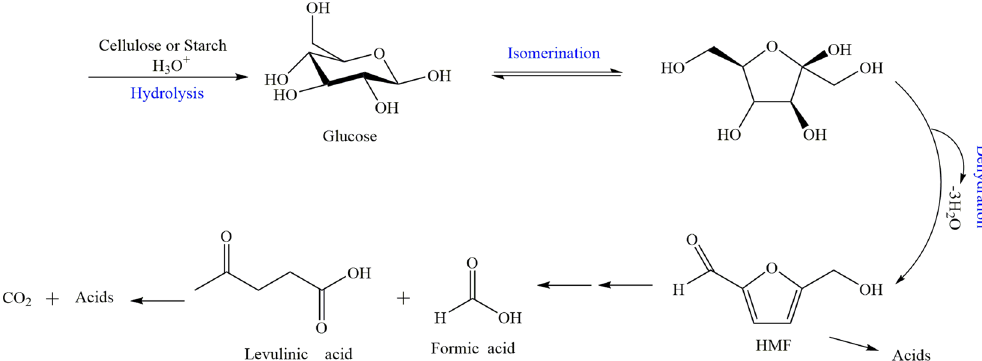
Figure 6. A possible reaction path of glucose oxidation in the LCFC.